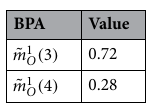
Table 6. BPAs based on Murphy combination